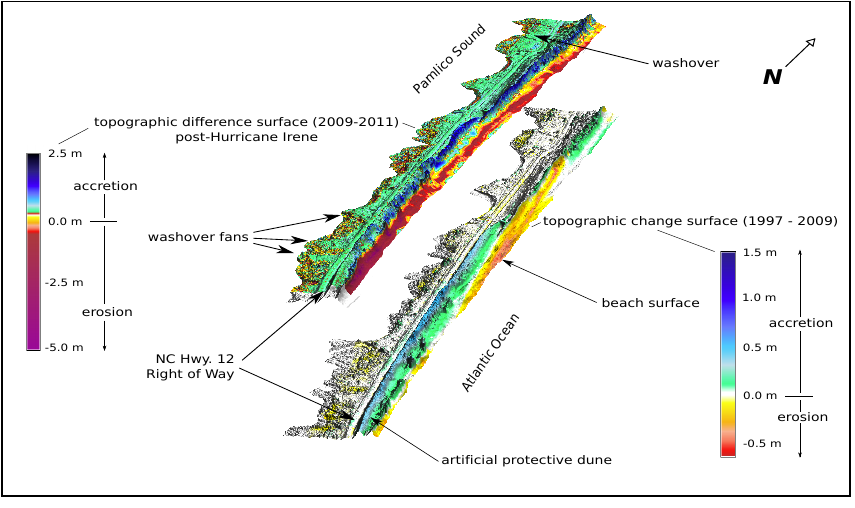
Figure 7. Hatteras Island site change surface (lower model)estimated using per-cell linear regression for the time period 1997–2005. DEMs for 1996, 2001 and 2009 were used to develop the model. The upper graphic (model) was developed using DEM differencing over the period 2009–2011, using the respective 2009 and 2011 DEMs in the computation. Both models show change in island topography (distribution and magnitudes of erosion and/or accretion, in meters) during the representative time